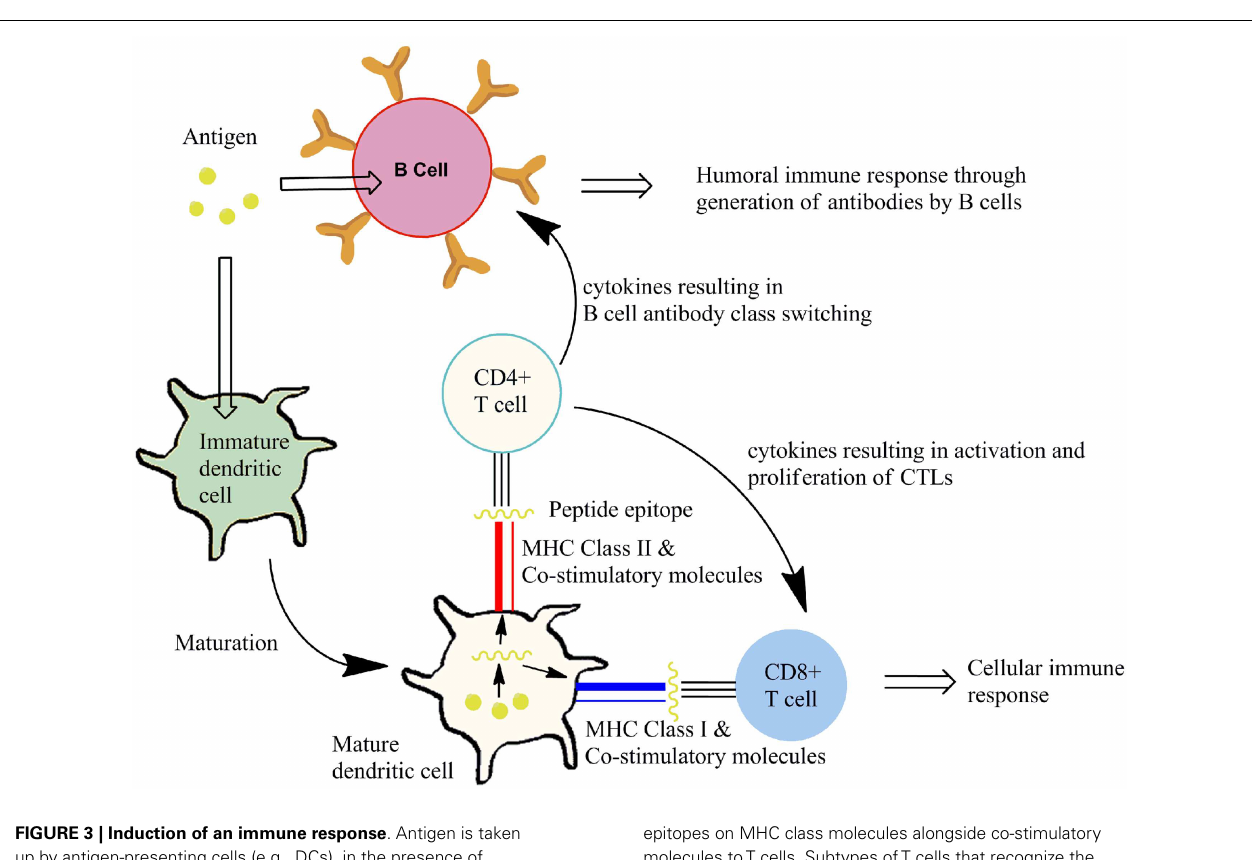
FIGURE 3 | Induction of an immune response . Antigen is taken up by antigen-presenting cells (e.g., DCs), in the presence of immunostimulatory molecules, resulting in DC maturation.This maturation process involves processing of antigen to display peptide